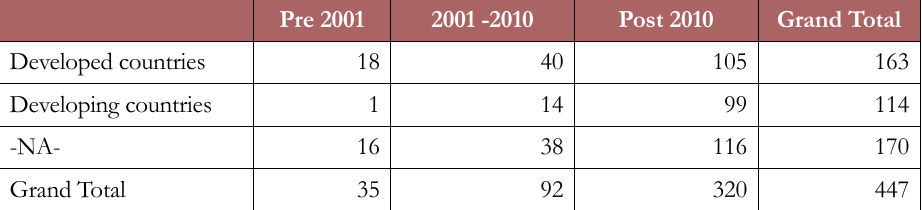
Table 5. Country Classification of Lean Studies